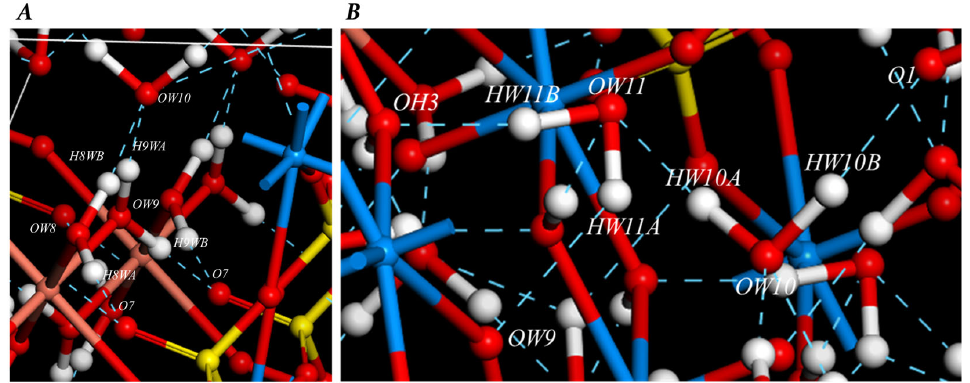
Table 2. Hydrogen bond parameters in johannite (distances are given in Å and angles in degrees).